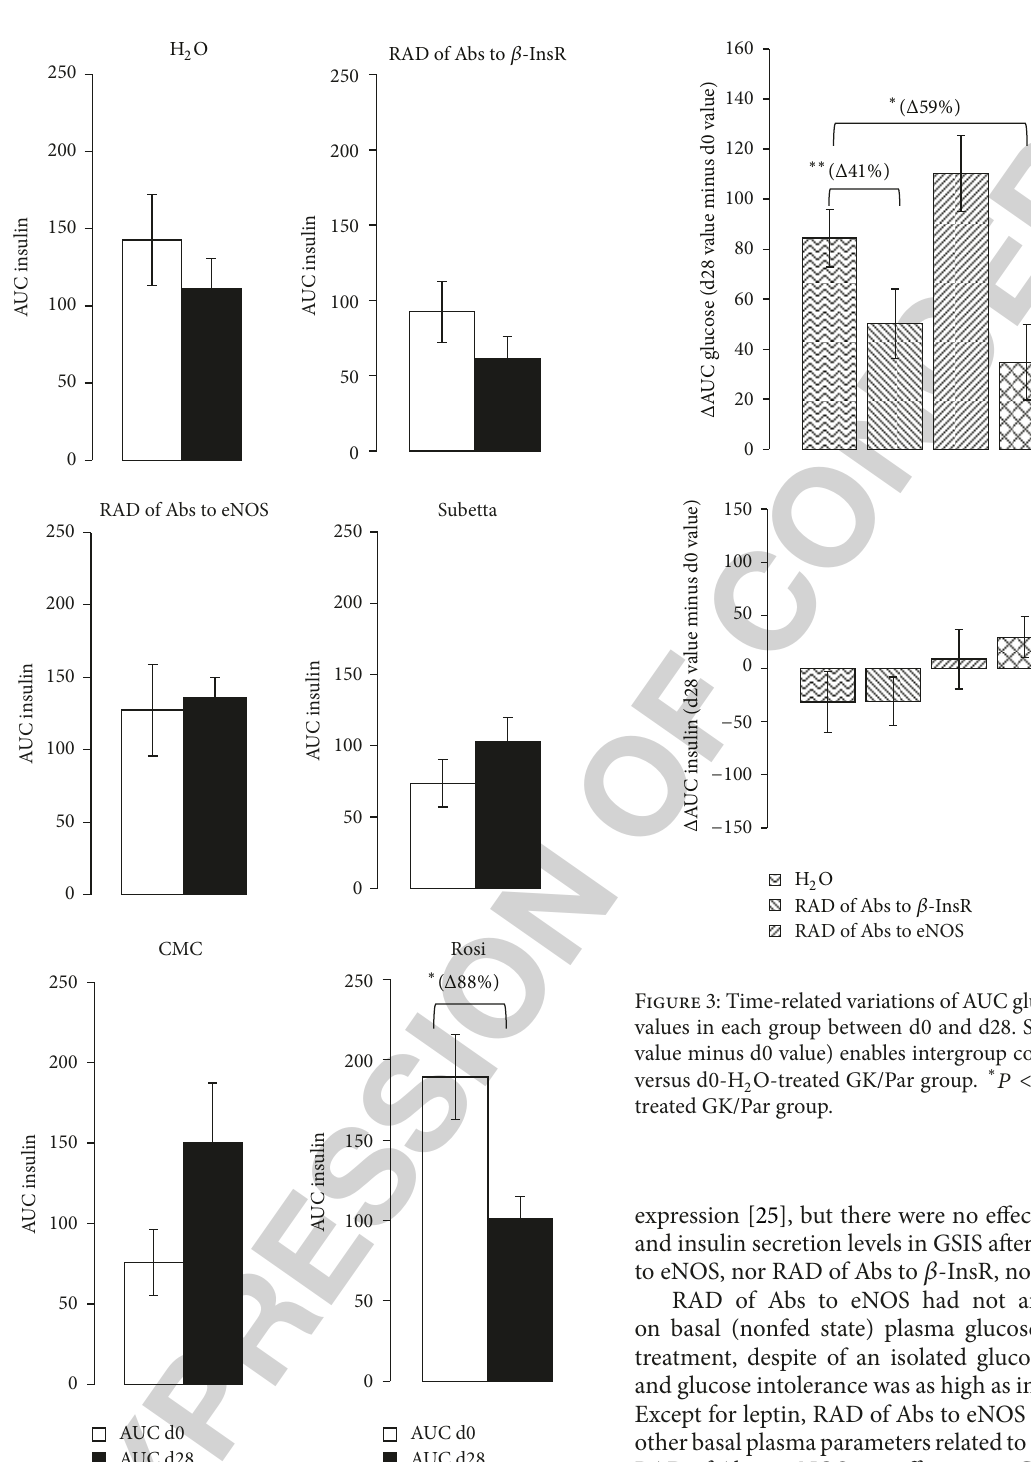
Figure 2: Insulin secretion in response to glucose (2g/kg per os) in adult diabetic male GK/Par rats before (d0) and after chronic treat- ment(d28)withRADofAbsto 𝛽 -InsR,RADofAbstoeNOS,Subet- ta, H 2 O (distilled water), Rosiglitazone (Rosi), or carboxy-methyl- cellulose (CMC). Insulin responses during the glucose tolerance test were calculated as incremental plasma insulin values integrated over the 120min period following the glucose injection (AUC insulin; g/L/120min). Each point represents the mean ± S.E.M. of 12 obser- vations/group. ∗ 𝑃 < 0.05 versus d0-ROSI-treated GK/Par group.